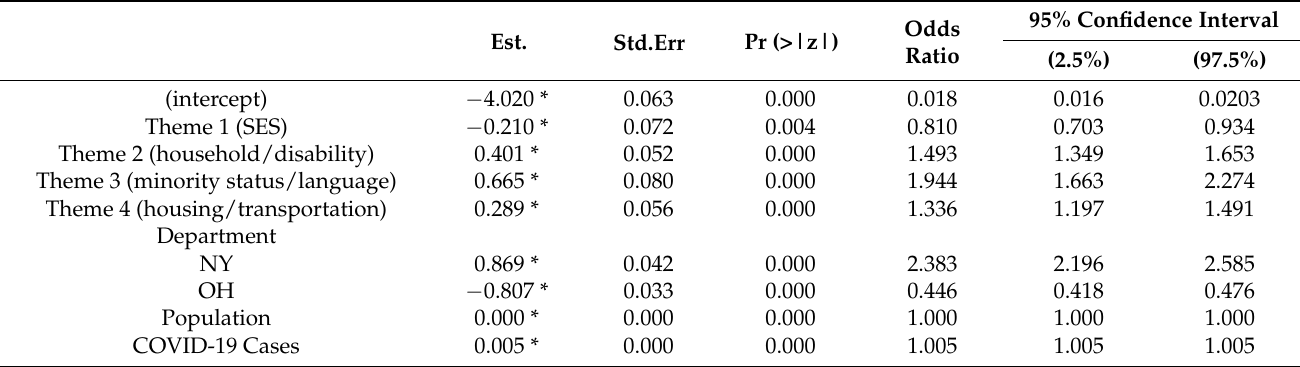
Table 5. Summary of logit regression results.